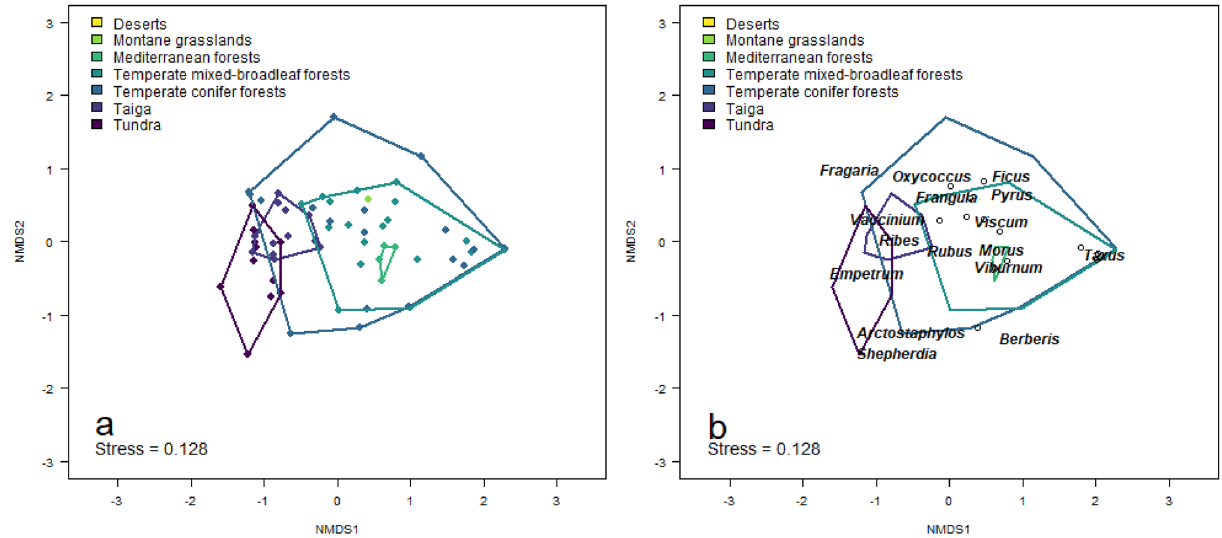
Figure 2. Nonmetric multidimensional scaling ordination plots illustrating differences in the contribution of fleshy-fruited plant genera consumed by brown bears across biomes. These differences are based on the relative frequency of occurrence of each genus in brown bear diet in 66 study areas. The location within the ordination plot of the study areas from which data were gathered ( a ) and the fleshy-fruited plant genera eaten by brown bears ( b ) are shown. Shepherdia and Empetrum are consumed by brown bears mostly in boreal biomes (i.e. tundra and taiga; left part in b ), while Vaccinium and Ribes are eaten in both boreal and temperate regions